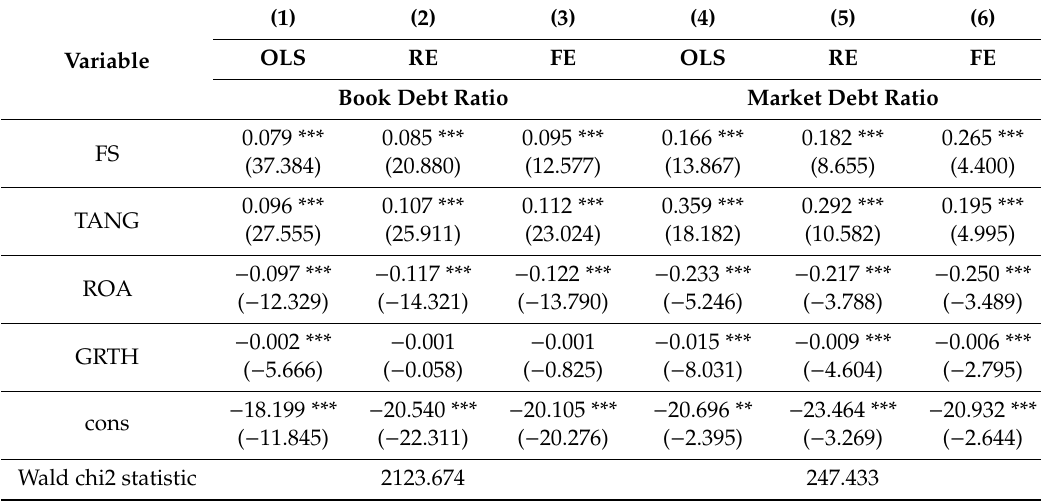
Table 1. Regression analysis for baseline model. Table 1 shows the results of regression analysis for